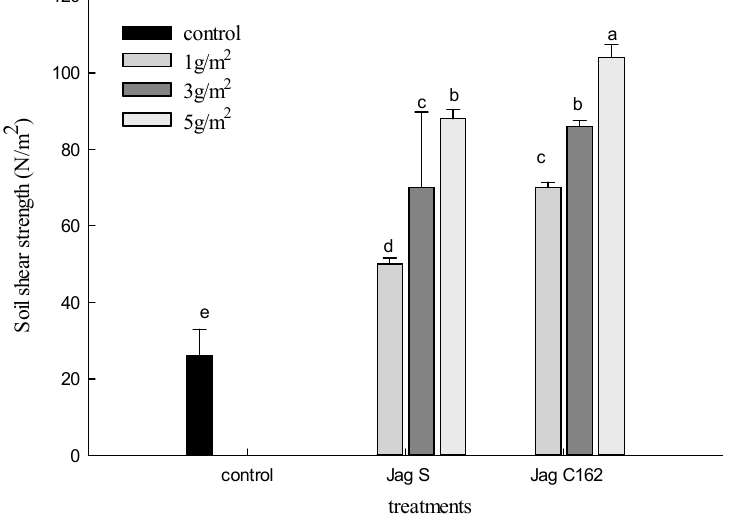
Figure 2. Effects of Jag S and Jag C162 on soil shear strength. The letters “a”–“e” represent significant